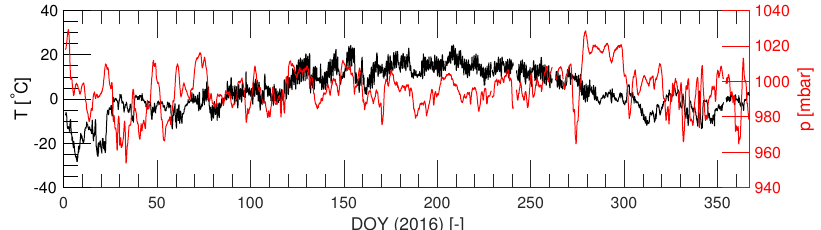
Figure A2. Annual temperature (black) and air pressure (red) registered in the Hyytiälä Forest Field Station during the year